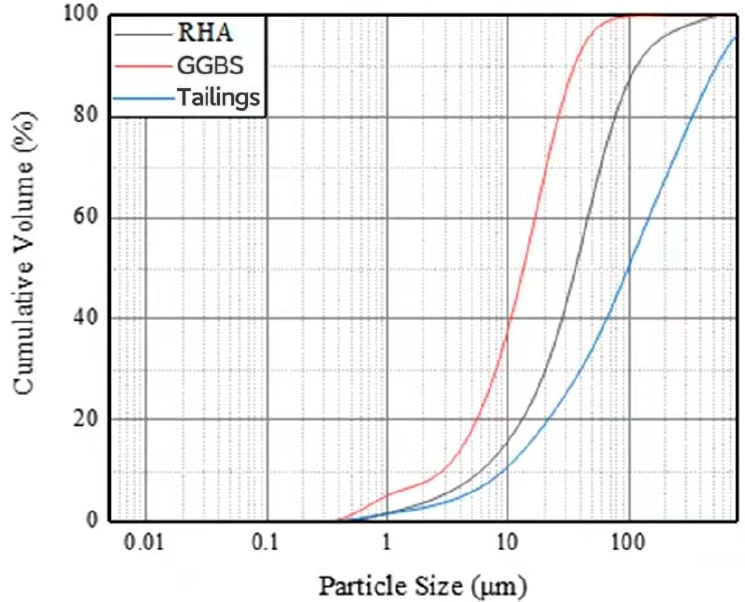
Figure 1. Particle size curve of cementitious material.